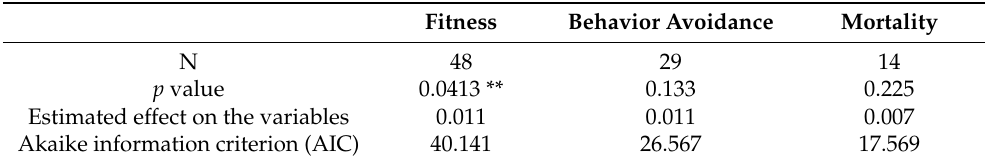
Table 1. Logistic regression of fitness, behavior avoidance, and mortality in relation to changes in pCO 2 (delta CO 2 , i.e., the difference between the upper and lower bounds of the CO 2 concentrations presented in the reviewed papers). Data is provided in Tables S1–S3. Fitness Behavior Avoidance Mortality N 48 29 14 p value 0.0413 ** 0.133 0.225 Estimated effect on the variables 0.011 0.011 0.007 Akaike information criterion (AIC) 40.141 26.567 17.569 ** p <